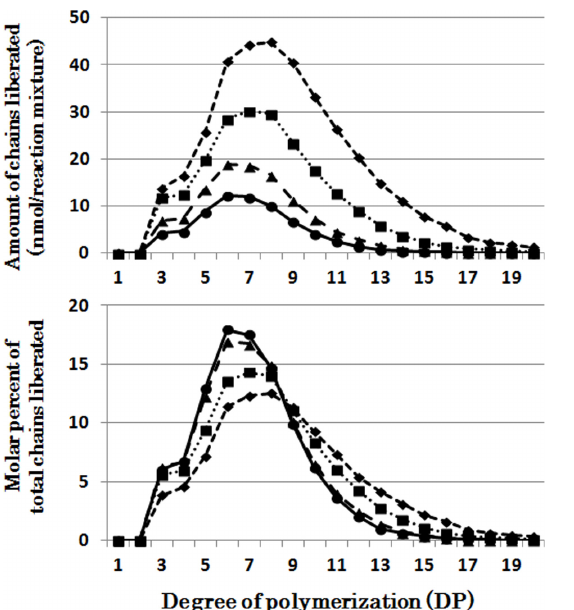
Fig 7. Chain-length preference of Pseudomonas amyloderamosa isoamylase (PsaISA) in debranching phytoglycogen. Upper panel shows the amount of chains liberated after enzymatic reaction with PsaISA and phytoglycogen for 5 ( ● ), 10 ( ▲ ), 30 ( ■ ), and 60 ( ♦ ) min, respectively. Lower panel shows the molar percentage of each liberated chain to the total liberated chains.